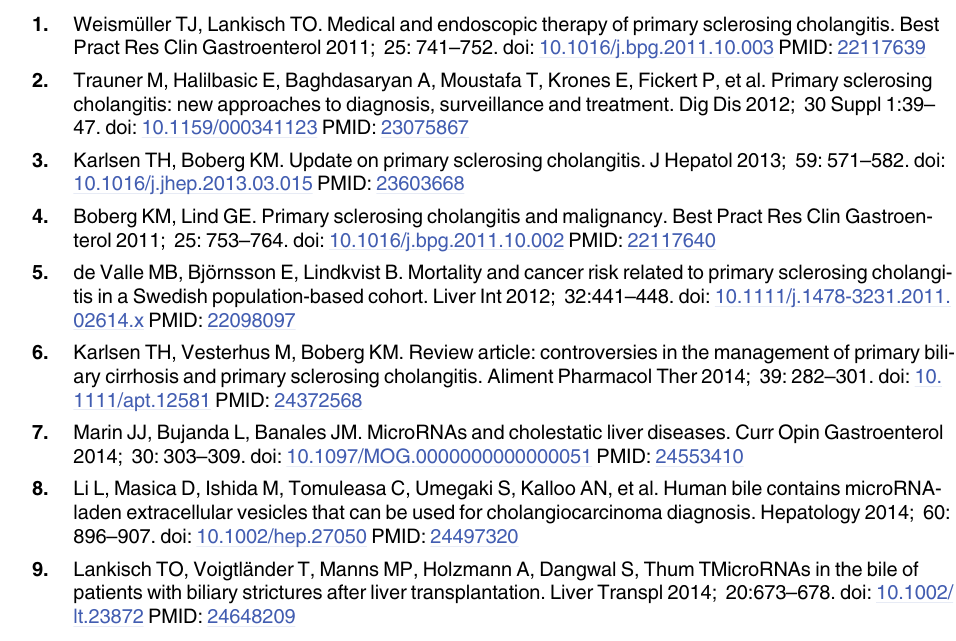
S4 Table. Array analysis for bile miRNAs (PSC and CC). Differentially expressed micro- RNAs with fold changes in bile of patients with primary sclerosing cholangitis (PSC) and cho- langiocarcinoma (CC). The upregulated miRNAs miR-215, miR-194, miR-132, miR-412, miR- 192 and downregulated miRNAs miR-1537, miR-640, miR-302b (cid:1) and miR-3189 were chosen for further validation. MiR-192 was chosen instead of miR-362-5p due to lower Ct-values in the array analysis. S5 Table. Correlation of bile miRNAs and bilirubin. All validated miRNAs in bile were ana- lyzed regarding correlation to bilirubin. No relevant correlation was detected. R: correlation